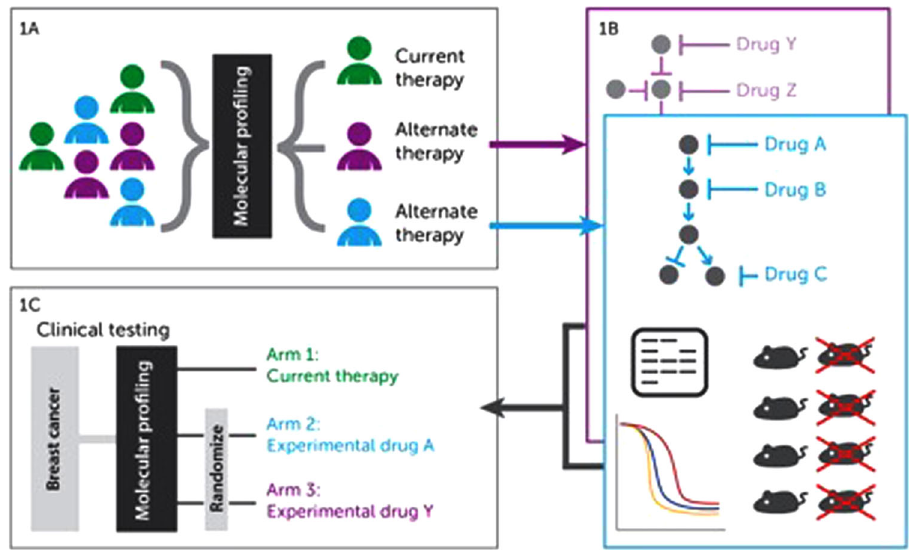
Fig. 1 Schema for addressing multiple breast cancer disease entities through integrated diagnostic assay, targeted therapeutic, and clinical trial strategies. Panel a : Molecular strati fi cation to identify treatment refractory tumors; ideally performed within uni fi ed patient cohorts or clinical trial biobanks. Green represents patients at low residual risk following standard of care (eligible for future monitoring or treatment reduction trials). Purple/blue patients are those with treatment refractory tumors with candidate molecular drivers. Panel b : Overview of preclinical validation for pathway drivers. Given extensive targeted drug portfolios repurposing of existing agents may act as a further accelerator to clinical validation. Panel c : Draft clinical trial schema – matching molecular strata ( purple/blue ) to repurposed